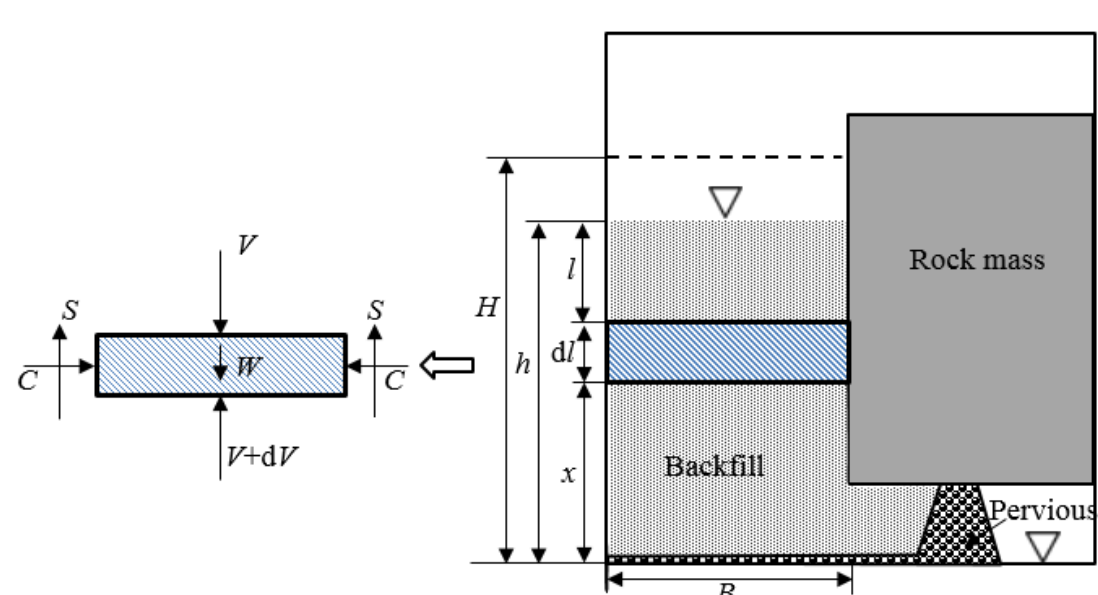
Figure 1. Schematic diagram of a vertical backfilled stope with a pervious base and continuously filled with slurried backfill.